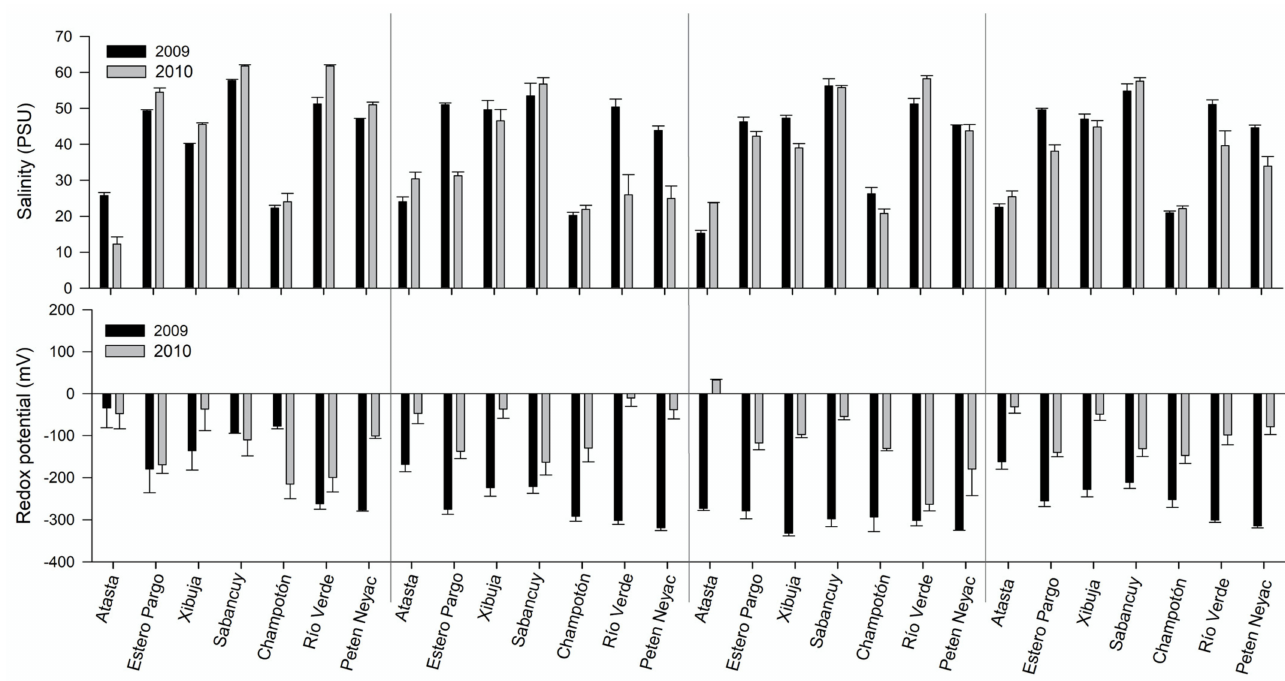
Figure 8. Pore-water salinity and redox potential ( ± SE = standard error) in seven mangrove forests along the coast of Campeche, Mexico.